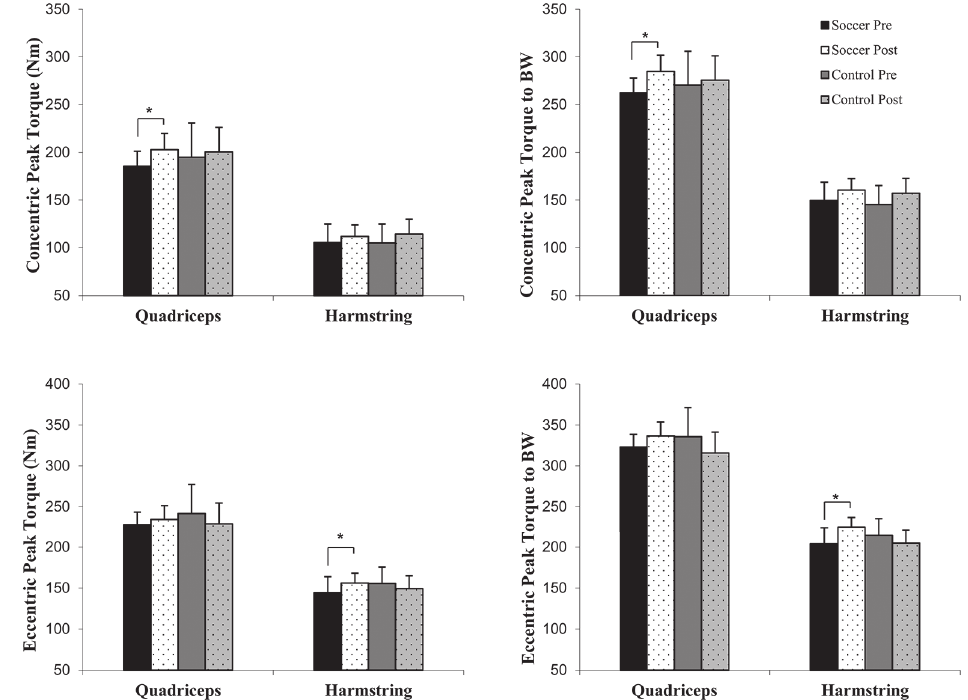
FIGURE 2 Weekly recreational soccer intervention induced changes in isokinetic strength performance over 8 weeks Note. *signifi cantly high er than pre-test values at